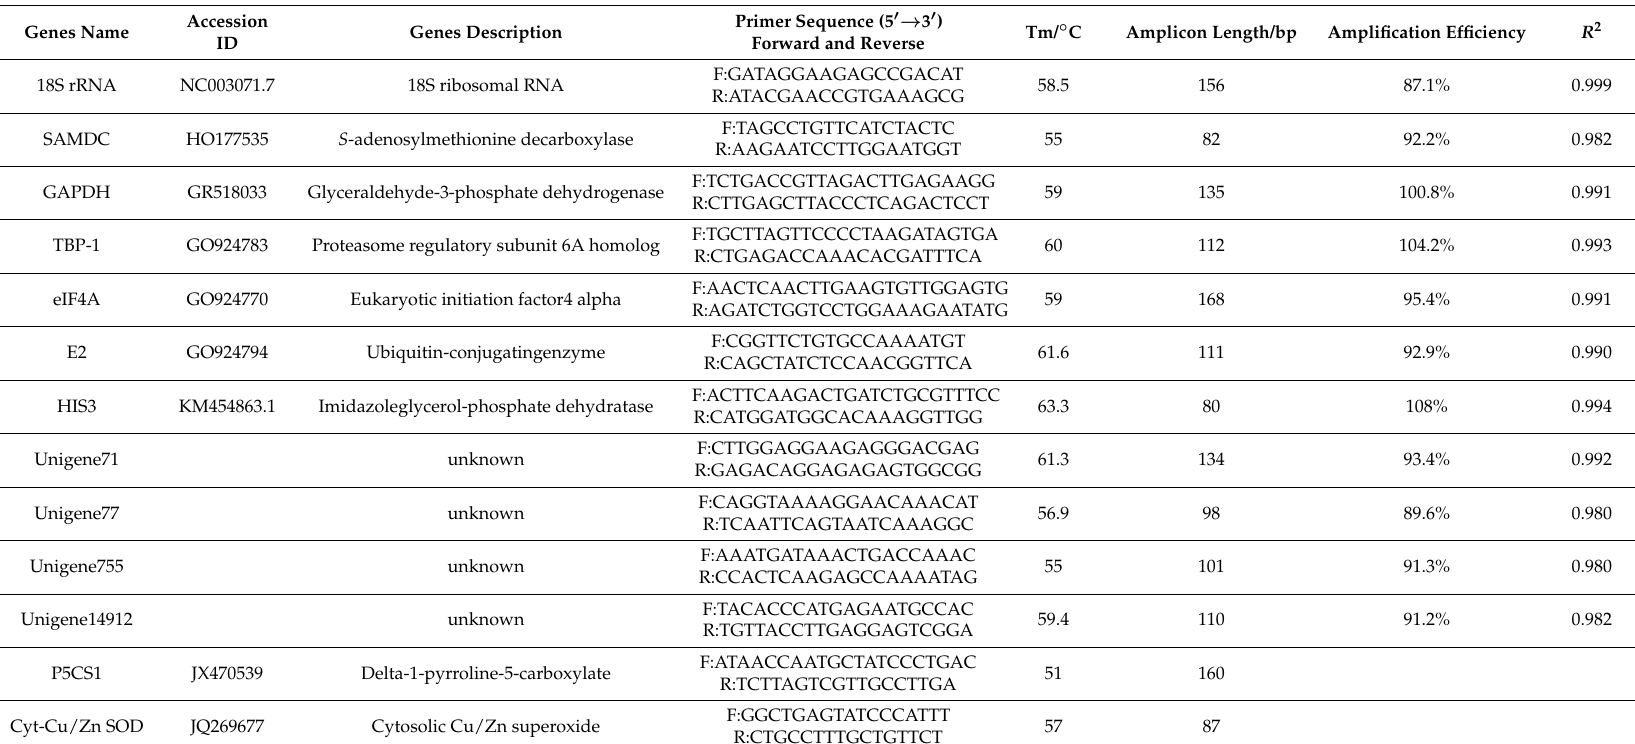
Table 4. Primer sequences for eleven reference genes used in the real-time qRT-PCR